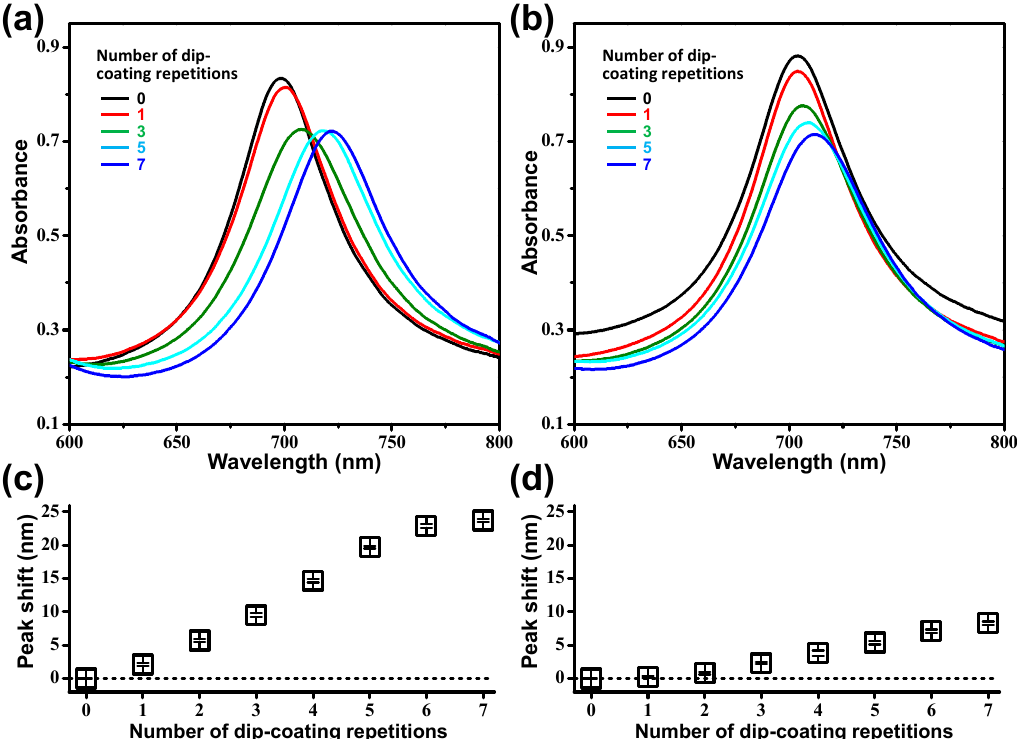
Figure 3. ( a , b ) Absorbance curves and ( c , d ) localized surface plasmon resonance (LSPR) peak shifts of PS bead-coated DAS arrays as functions of the number of dip-coating repetition cycles. The data in Figure 3a,c and Figure 3b,d were obtained from the par-dip and per-dip samples, respectively. All the data in Figure 3c,d showed statistically significant differences (P-value < 0.05), except for the first two data in Figure 3d (single and double dip coatings).